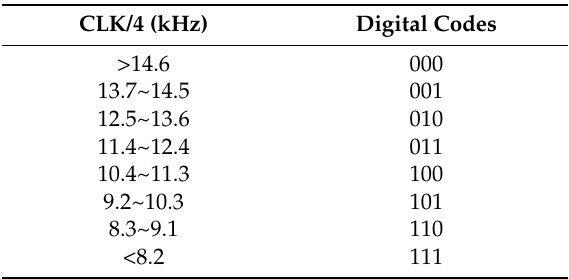
Table 1. Digital Codes under Different Input Clocks.